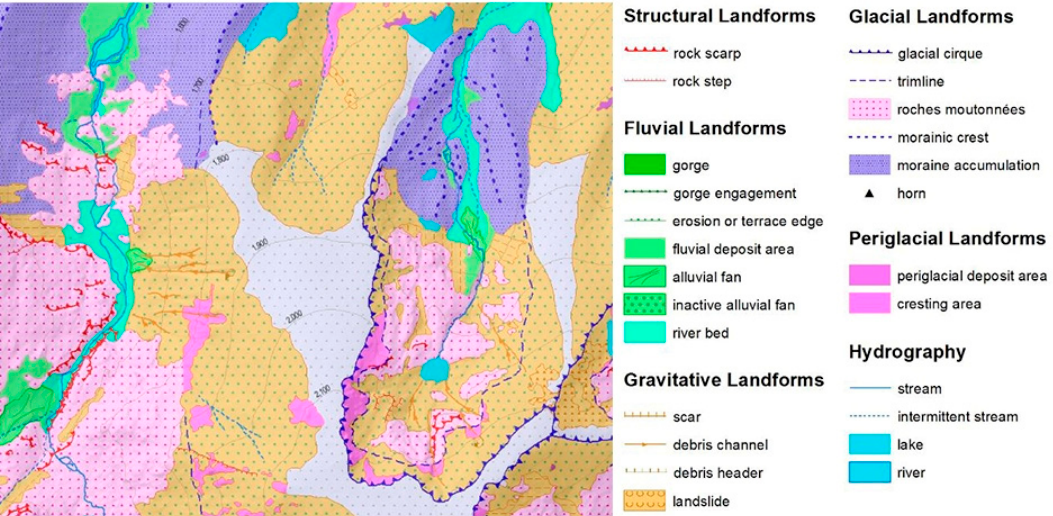
Figure 2. Part of a geomorphological map (left) of La Covacha massif (Iberian Central System) from Campos et al. [30], with a scale 1:10,000. The legend ( right ) is a combination of those from the IGUL [51] and Peña et al. [48].